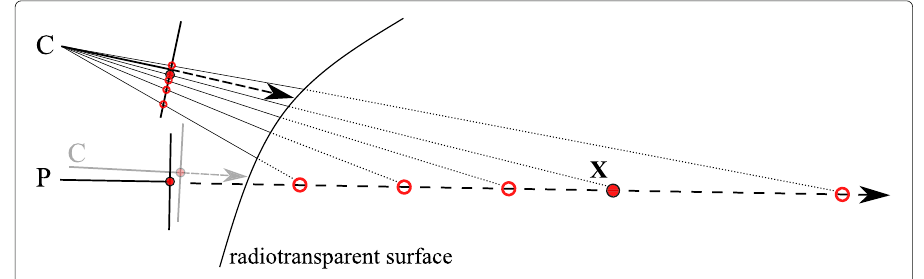
Fig. 5 An active source ( X ) is projected along the view axis of the pinhole (P). By not knowing the true depth, any of some possible positions (circles) could be projected onto the image plane of P. This ambiguity cannot be resolved to correctly augment the image produced by the optical camera (C) with information from P. However, by moving C as close as possible to P (light gray), their respective projections converge. Adding a depth estimate improves the accuracy of the image augmentation further. Note the differences between the mapped projections of the image plane of C. We observe that with increasing distance these differences decrease, yielding a decaying error curve ( cf. the “Error quantification”